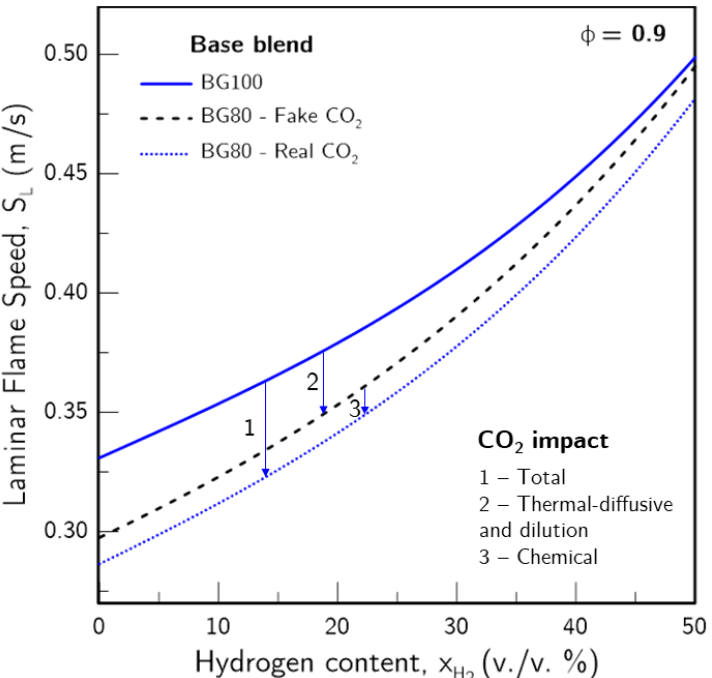
Figure 4. Laminar flame speed of BG100, BG80 and BG80 (FCO Each line corresponds to the model results for a determined base blend. Conditions were set at p = 1atm and T u =